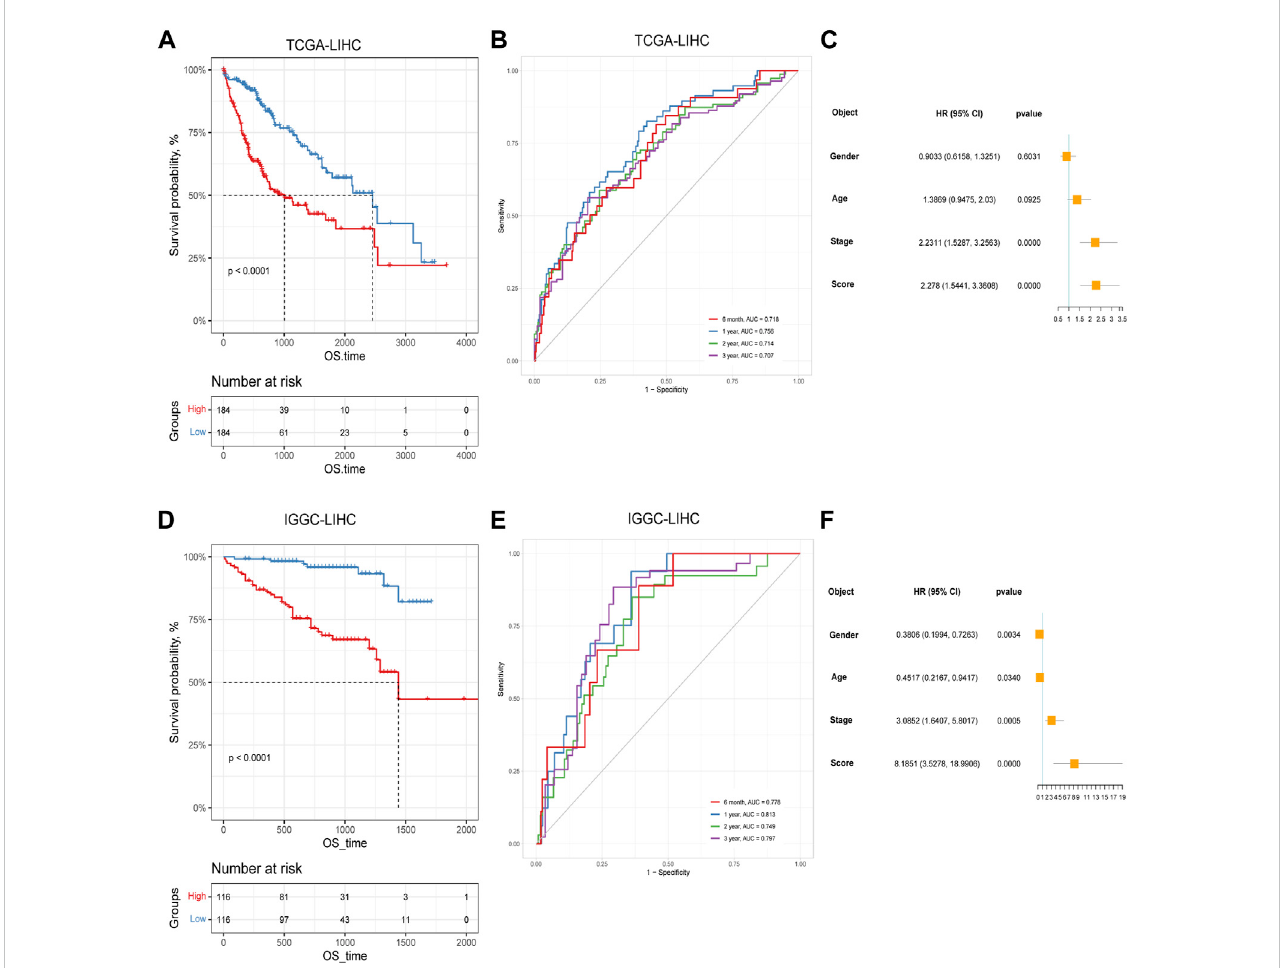
FIGURE 6 The prognostic effect of cuproptosis-related genes signatures in hepatocellular carcinoma. (A) Survival analysis of patients in TCGA cohort based on cuproptosis score; (B) Time-dependent receiver operating characteristic (ROC) curve of cuproptosis score in TCGA dataset; (C) Multivariate Cox analysis results in TCGA dataset; (D) Survival analysis of patients in LIRI-JP cohort based on cuproptosis score; (E) ROC curve of cuproptosis score in the LIRI-JP dataset; (F) Multivariate Cox analysis results in LIRI-JP